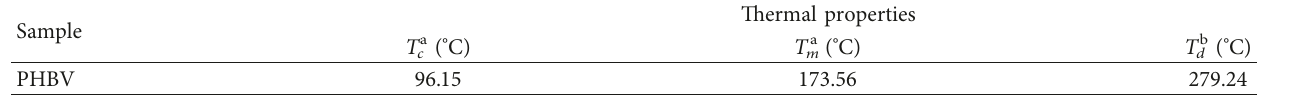
Table 1: Thermal properties of PHBV.